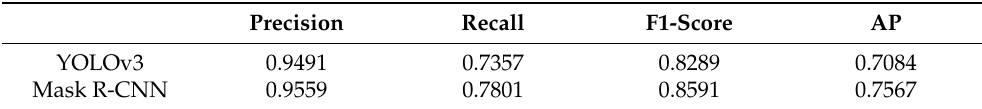
Figure 5. The detection results of the baseline model trained on the Utah city dataset. The top, middle, and bottom rows show the bounding boxes of GT, YOLOv3, and Mask R-CNN outputs, respectively. Table 1. Precision, Recall, F1-score, and AP of the baseline